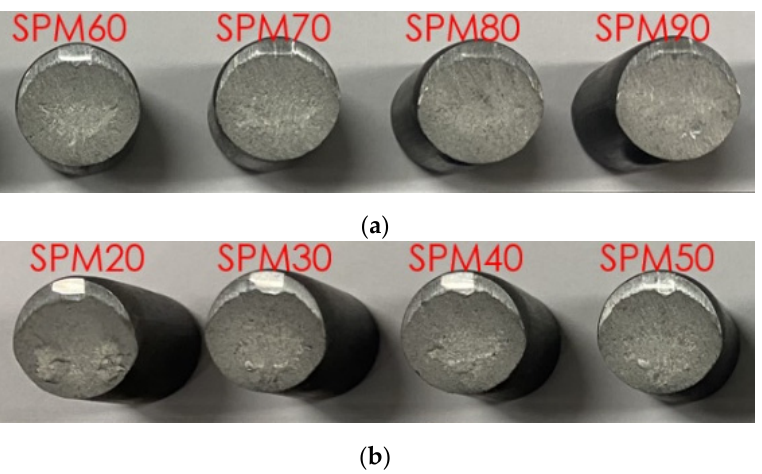
Figure 9. Effect of speed of rod shearing in automatic multi-stage cold forging on the quality of the sheared surface: ( a ) Good sheared surface; ( b ) Bad sheared surface. SPM stands for “strokes per minute”.